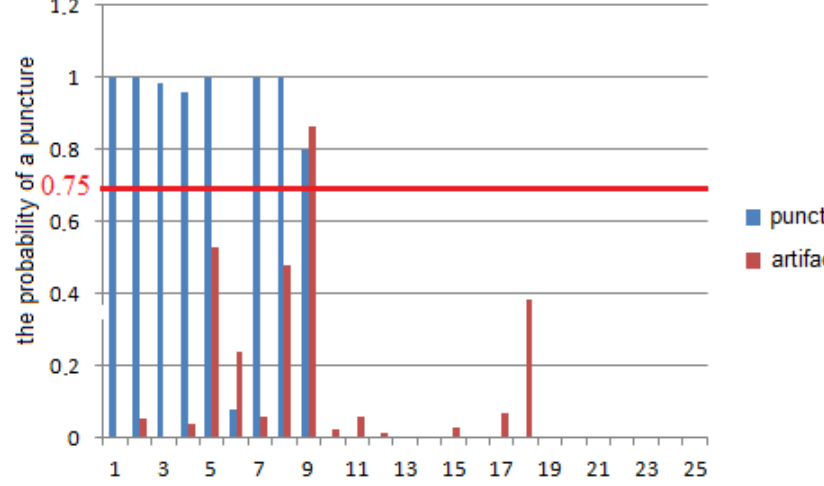
Figure 10. The result of model approbation on the control